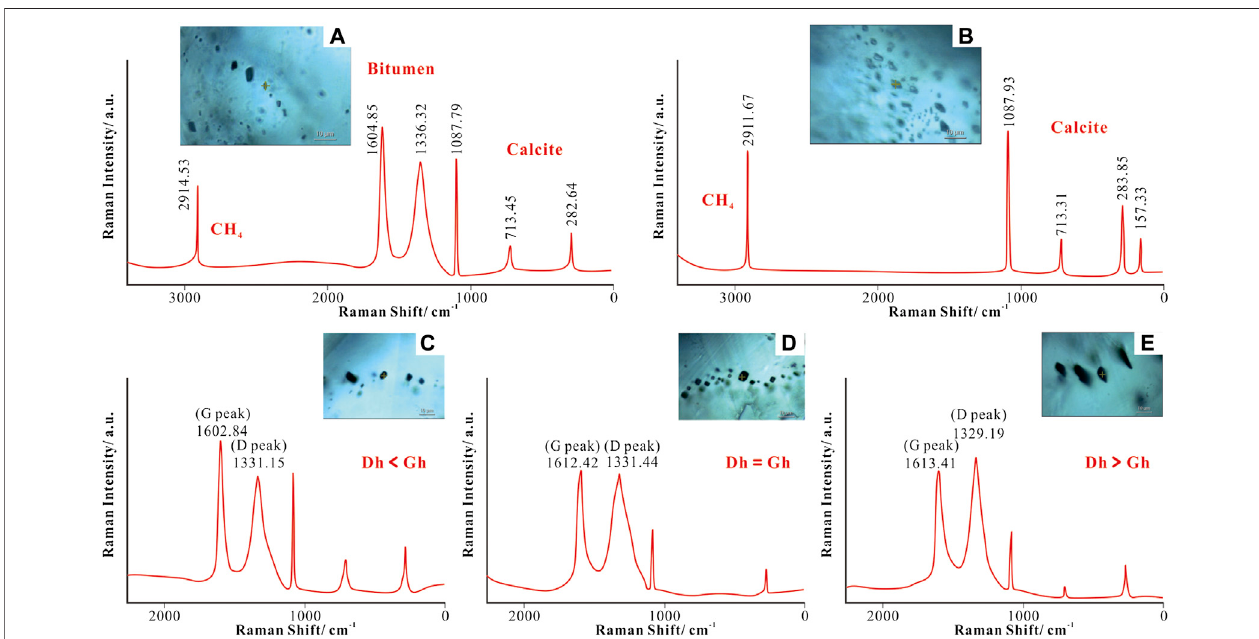
FIGURE 5 | Raman spectrum of FI. (A) Methane-bearing bituminous inclusions existed in calcite, and the inclusions have one or more black lines on the sidewalls and are brighter in the middle (sample N228-3470.1 m). (B) Methane inclusions existed in calcite, with bright in the middle and surrounded by light gray (sample N228- 3479.4 m). (C) Carbonaceous bituminous inclusions with Dh < Gh. (D) Carbonaceous-metamorphic bituminous inclusions with Dh = Gh. (E) Metamorphic bituminous inclusions with Dh >